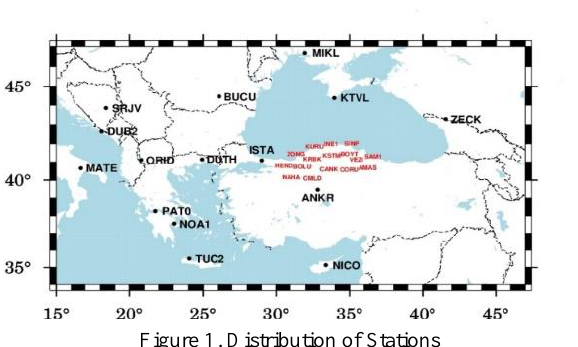
Figure 1. Distribution of Stations We produced TEC values using Bernese 5.0v program with two hours increments from eighth day to fifteenth day in January, April, July and October 2014. We also obtained Global ionosphere model (GIM) TEC values published by Center for Orbit Determination in Europe (CODE) and International Reference Ionosphere TEC (IRI-2012). While black label shows our results (GPS), green and red labels indicate IRI and GIM results respectively in Figure 2.